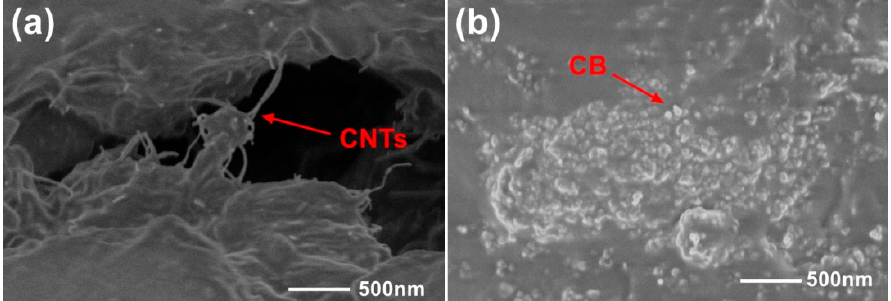
Figure 3. SEM images of internal of nanocomposites. ( a ) Multi-walled carbon nanotubes